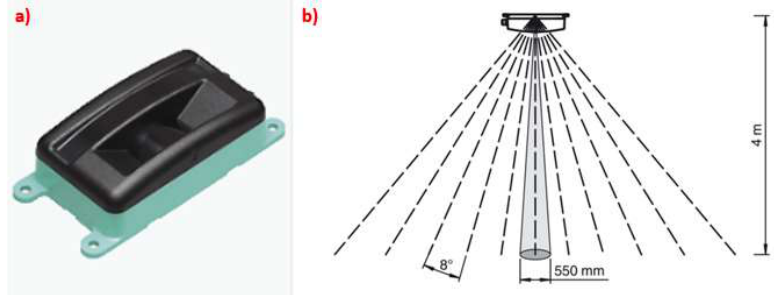
Figure 1. ( a ) Laser scanner OMD8000-R2100-B16-2V15. ( b ) Arrangement of the measurement